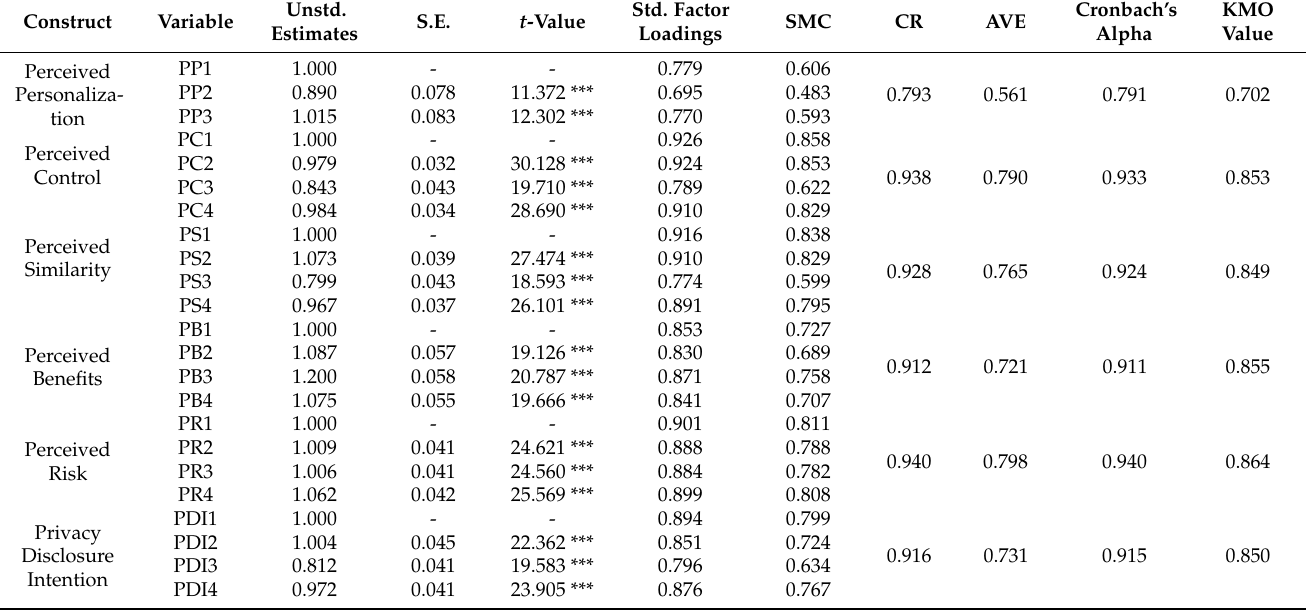
Table 2. Measurement coefficient of research model.